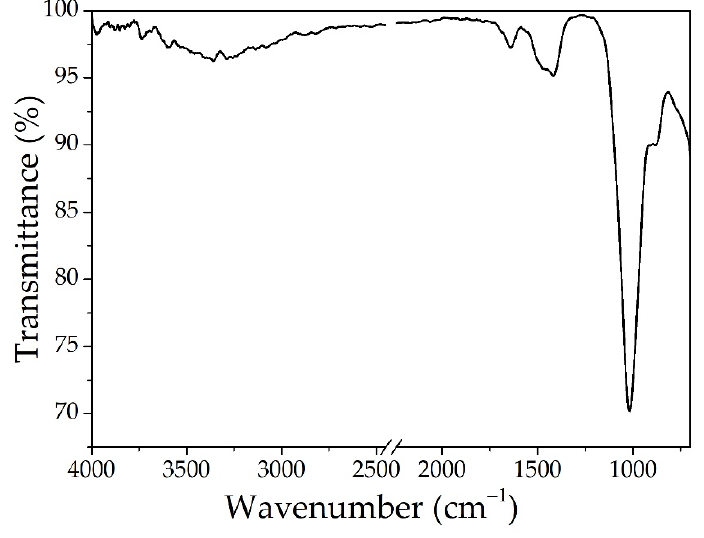
Figure 4. The ATR-FTIR analysis for BPA.